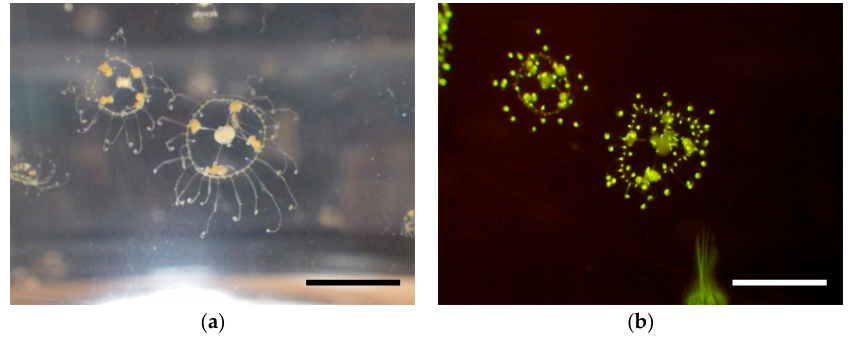
Figure 1. A jellyfish Scolionema suvaense . ( a ) Image under ambient light. ( b ) Fluorescence image under blue LED (470 nm) illumination. Green fluorescence was observed through an orange transparent acrylic plate (A300, Hikari Co., Ltd., (Osaka, Japan). Scale bars are 10